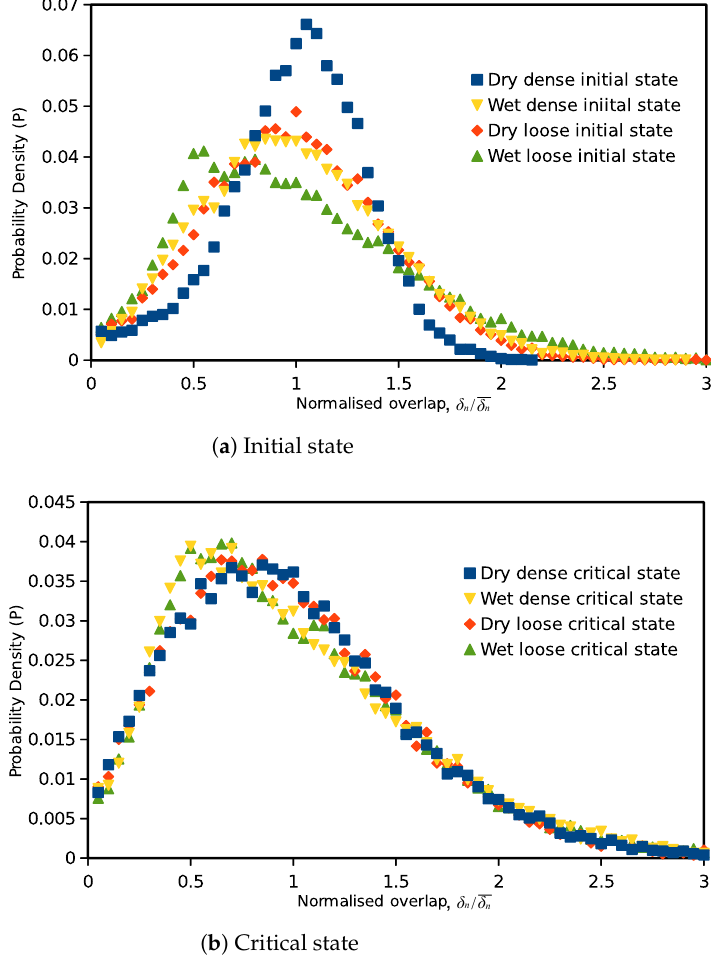
Figure 10. Initial and critical state probability distribution of normalized overlaps ( δ n / ¯ δ n ) in dry and wet